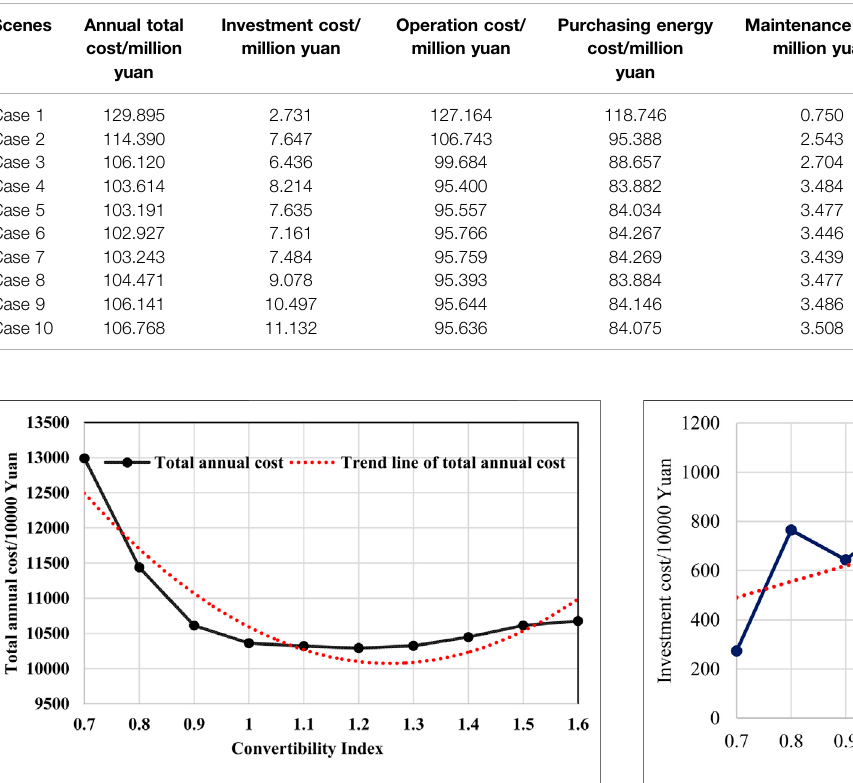
TABLE 9 | Costs of planning schemes under the constraints of different CIs.